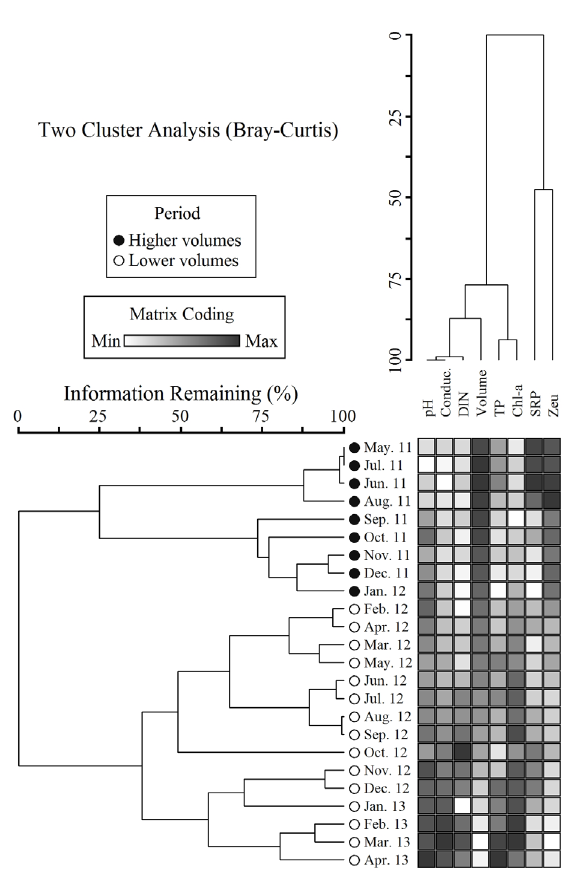
Figure 4. Two-way cluster analysis diagram of physical- chemical variables and monthly sampling. On the matrix, dark squares represent maximum values while white ones represent minimum values for each parameter (columns) during monthly samples